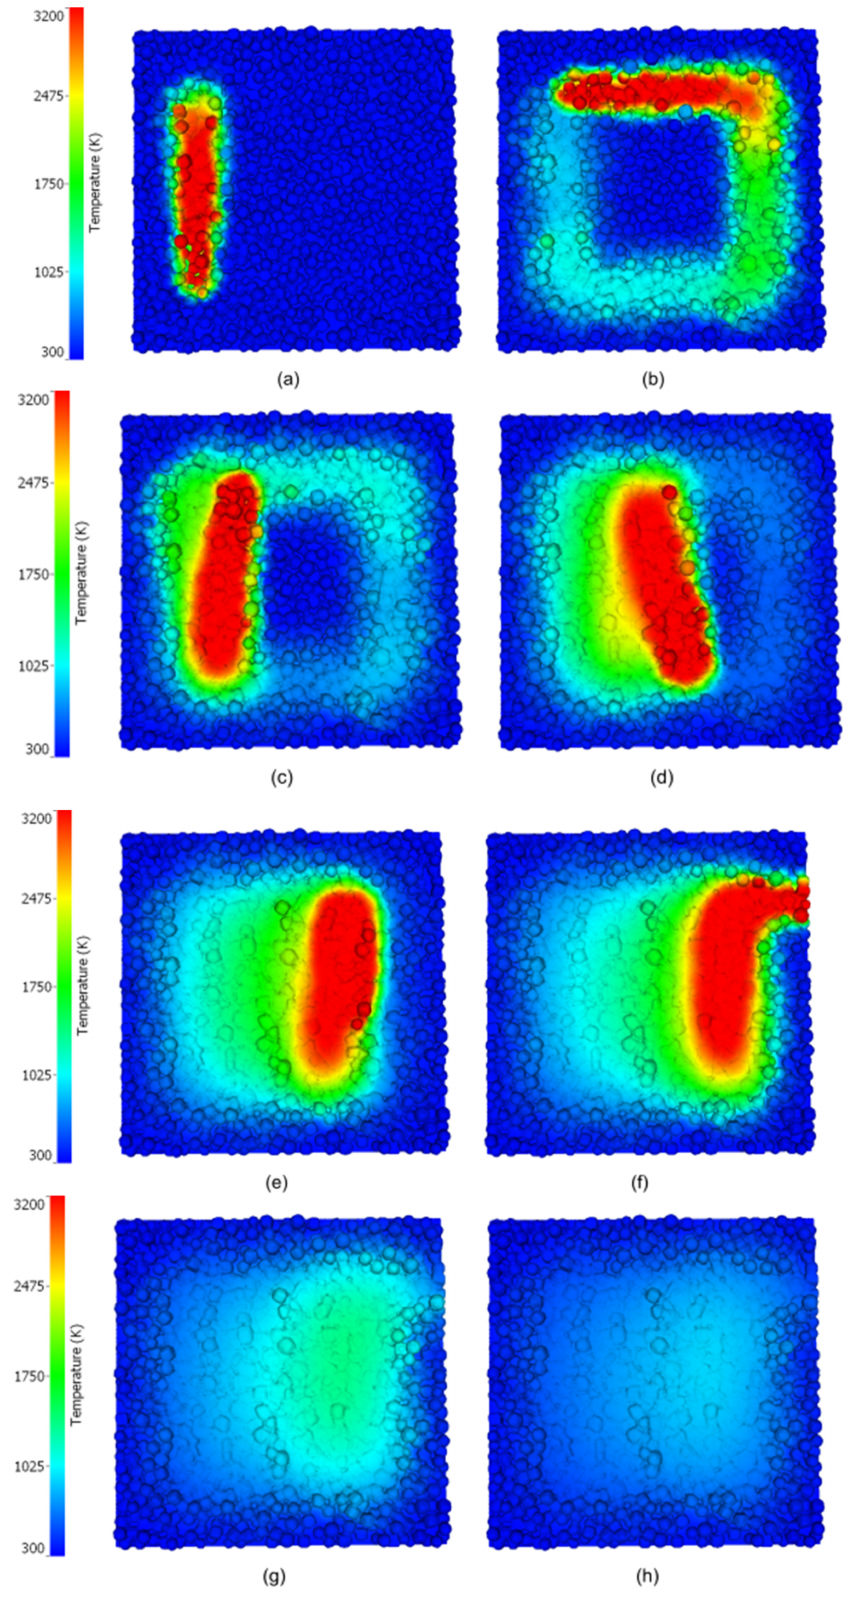
Figure 5. Temperature of the powder bed during and after the laser traversal at times ( a ) t = 1 ms; ( b ) t = 4 ms; ( c ) t = 6 ms; ( d ) t = 9 ms; ( e ) t = 12 ms; ( f ) t = 14 ms; ( g ) t = 18 ms; ( h ) t = 22